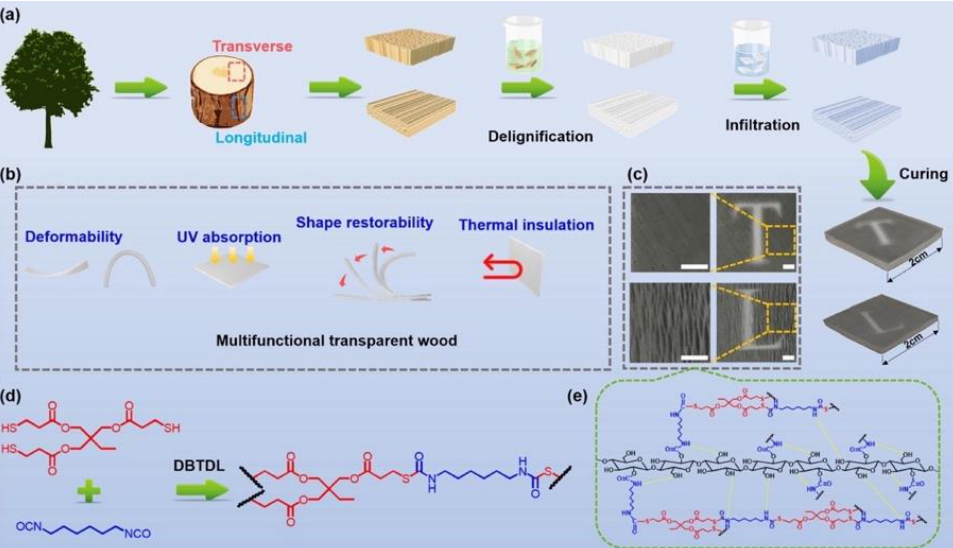
Figure 31. Synthesis process, multiple functions, macroscopic images, reaction scheme, and bonding mechanism of TWs. ( a ) Synthesis process of transparent wood. ( b ) Deformability, UV absorption, shape restorability, and thermal insulation functions of transparent wood. ( c ) Digital images of transparent wood at different magnification times (the inserted ruler indicates a length of 2 mm). ( d , e ) Reaction of vitrimers and bonding mechanism between cellulose and vitrimers. DBTDL = Dibutyltin dilaurate. Reprinted with permission from [47], copyright 2022, Elsevier.